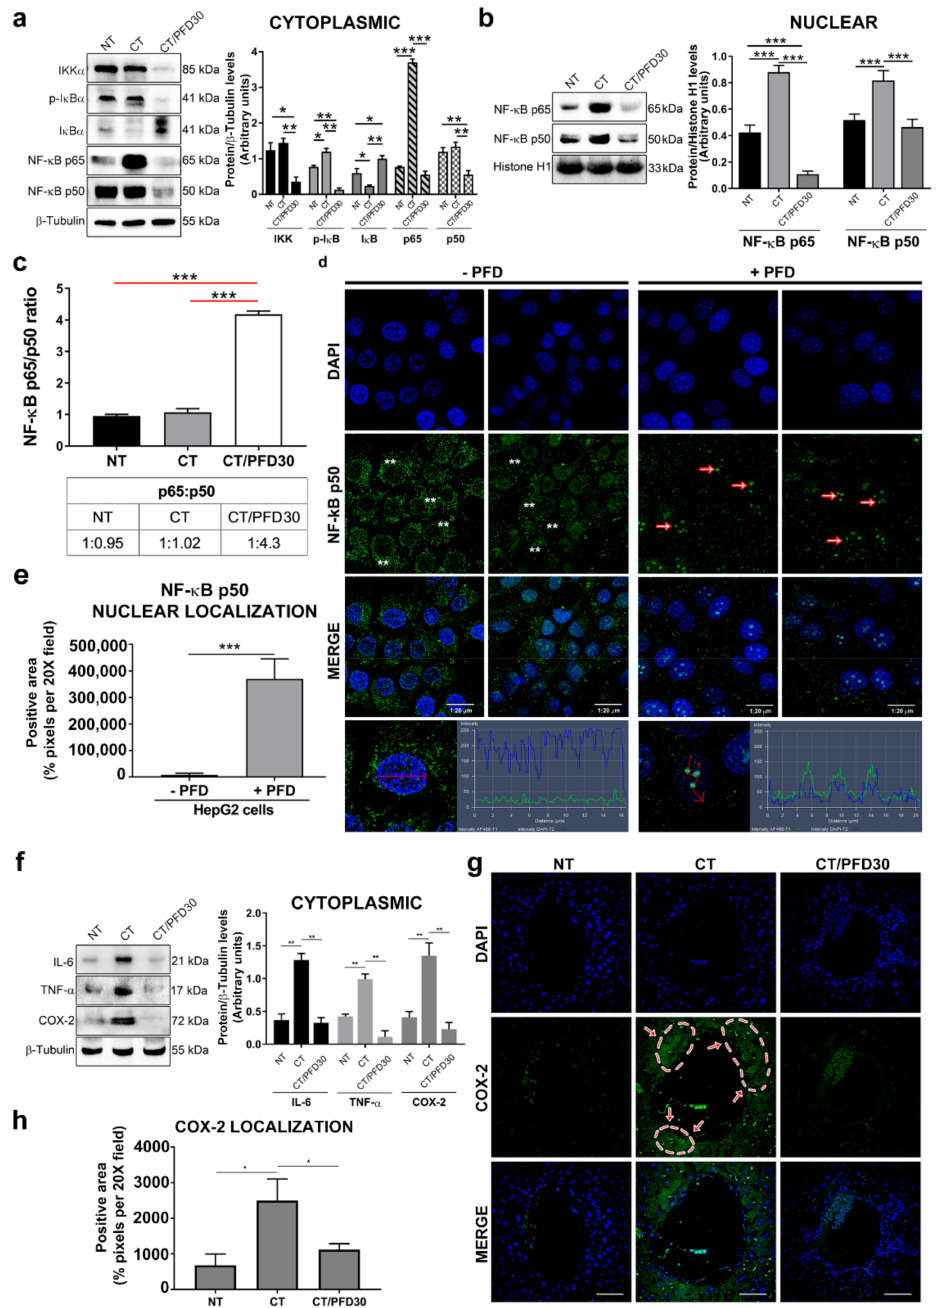
Figure 4. Pirfenidone reduced inflammation in MRHM and modified NF-kB p65/p50 ratio. ( a ) NF-kB activation cytoplasm cascade: IKK- α , p-IkB- α , IkB- α and NF-kB p65/p50 expression. ( b )